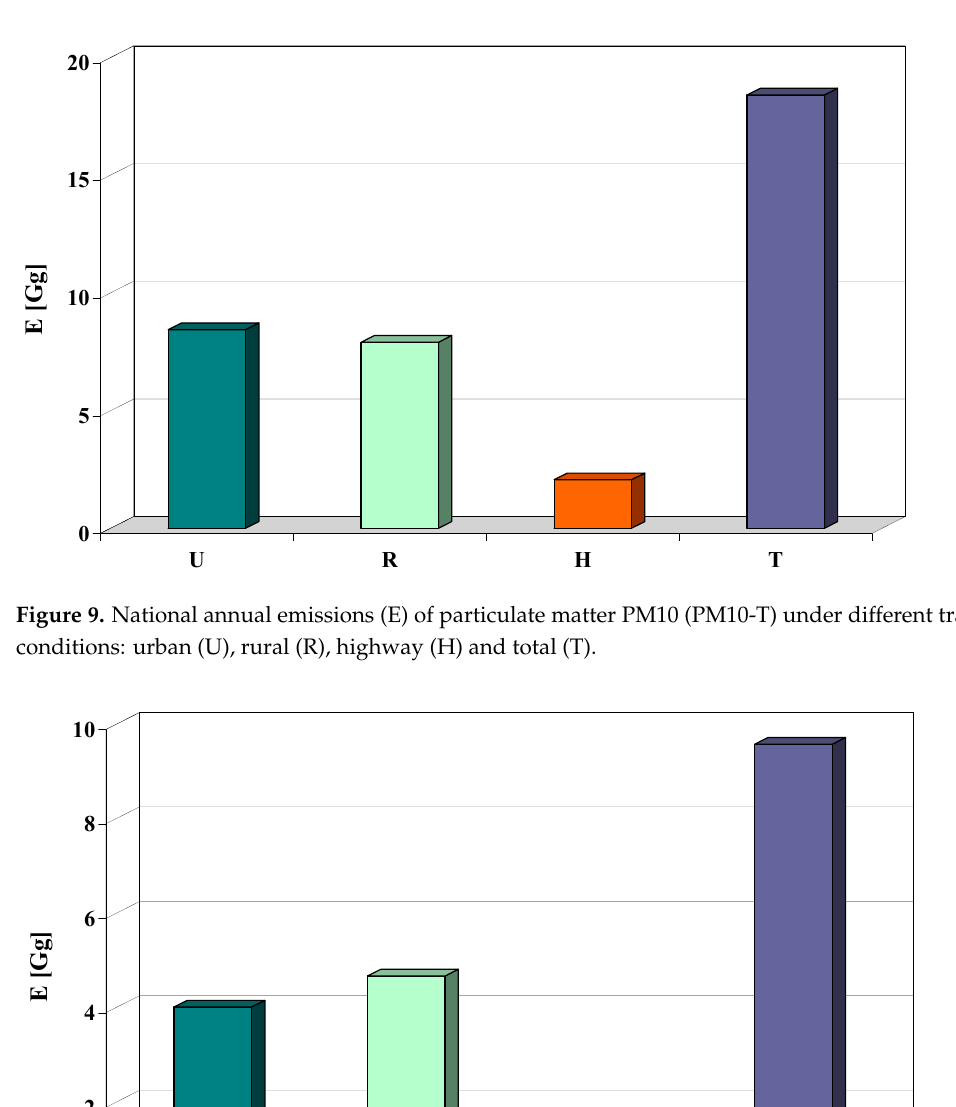
Figure 10. National annual emissions (E) of non-exhaust particulate matter PM10 (PM10-N-Exh) under different traffic conditions: urban (U), rural (R), highway (H) and total (T).